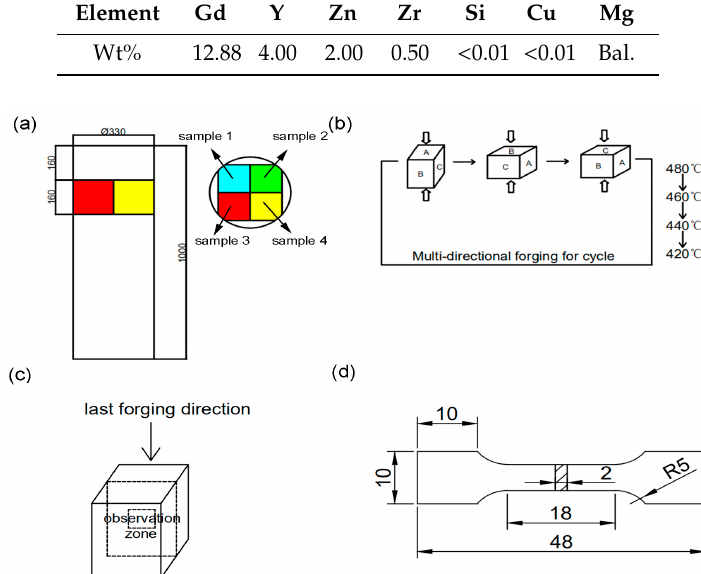
Figure 1. The chart of MDF process: ( a ) Conventional method, ( b ) high and low temperature cycle deformation process.